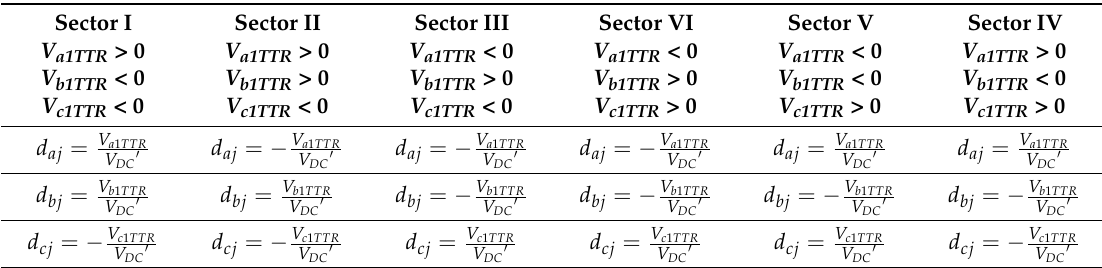
Table 2. d aj , d bj and d cj